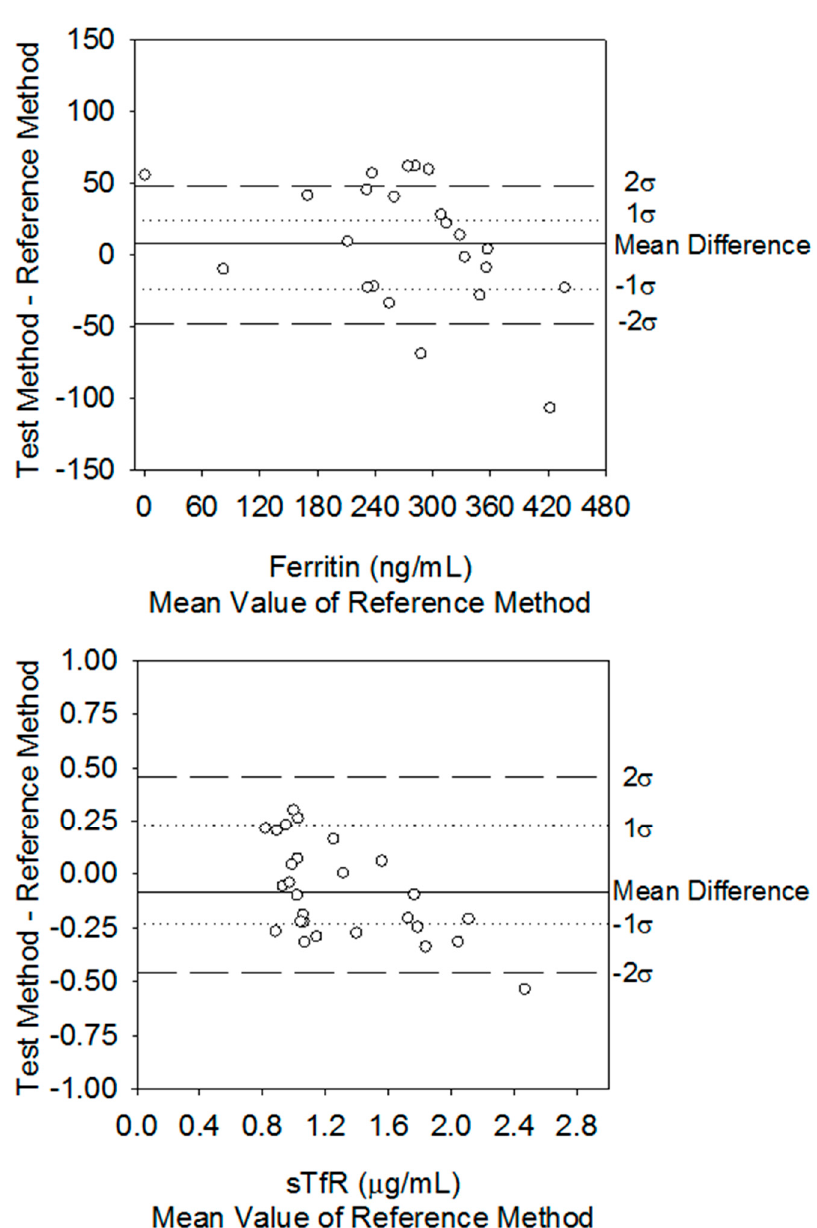
Figure 2. Difference plots comparing serum ferritin and sTfR concentrations from hemodialysis patients using the PC biosensor against the certified ELISAs.